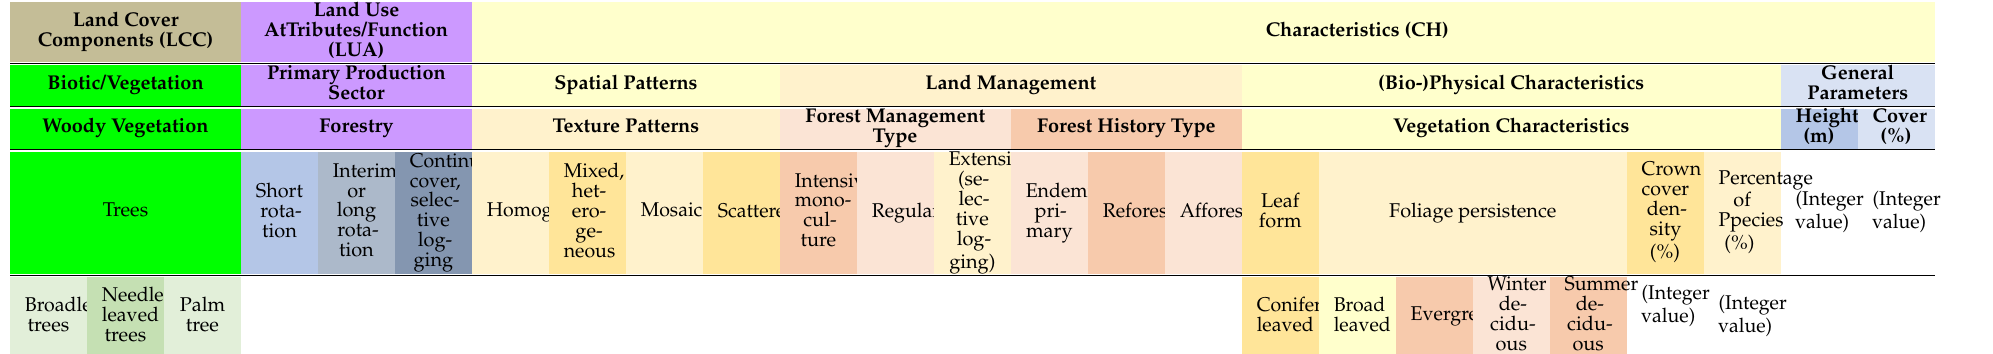
Table 5. Results of mapping based on term